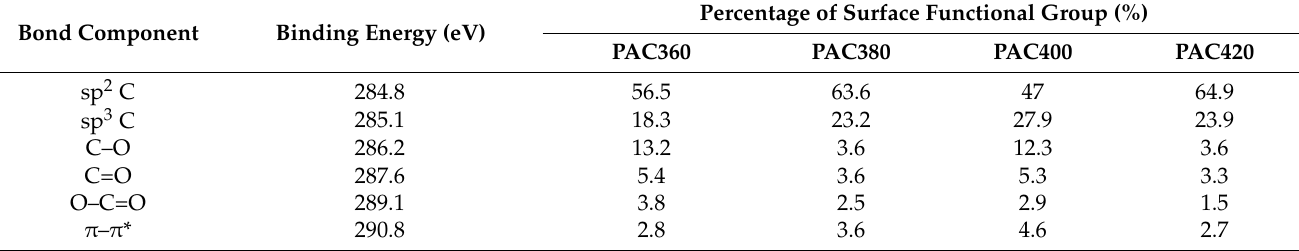
Table 3. Position and quantitative analysis of XPS C 1 s